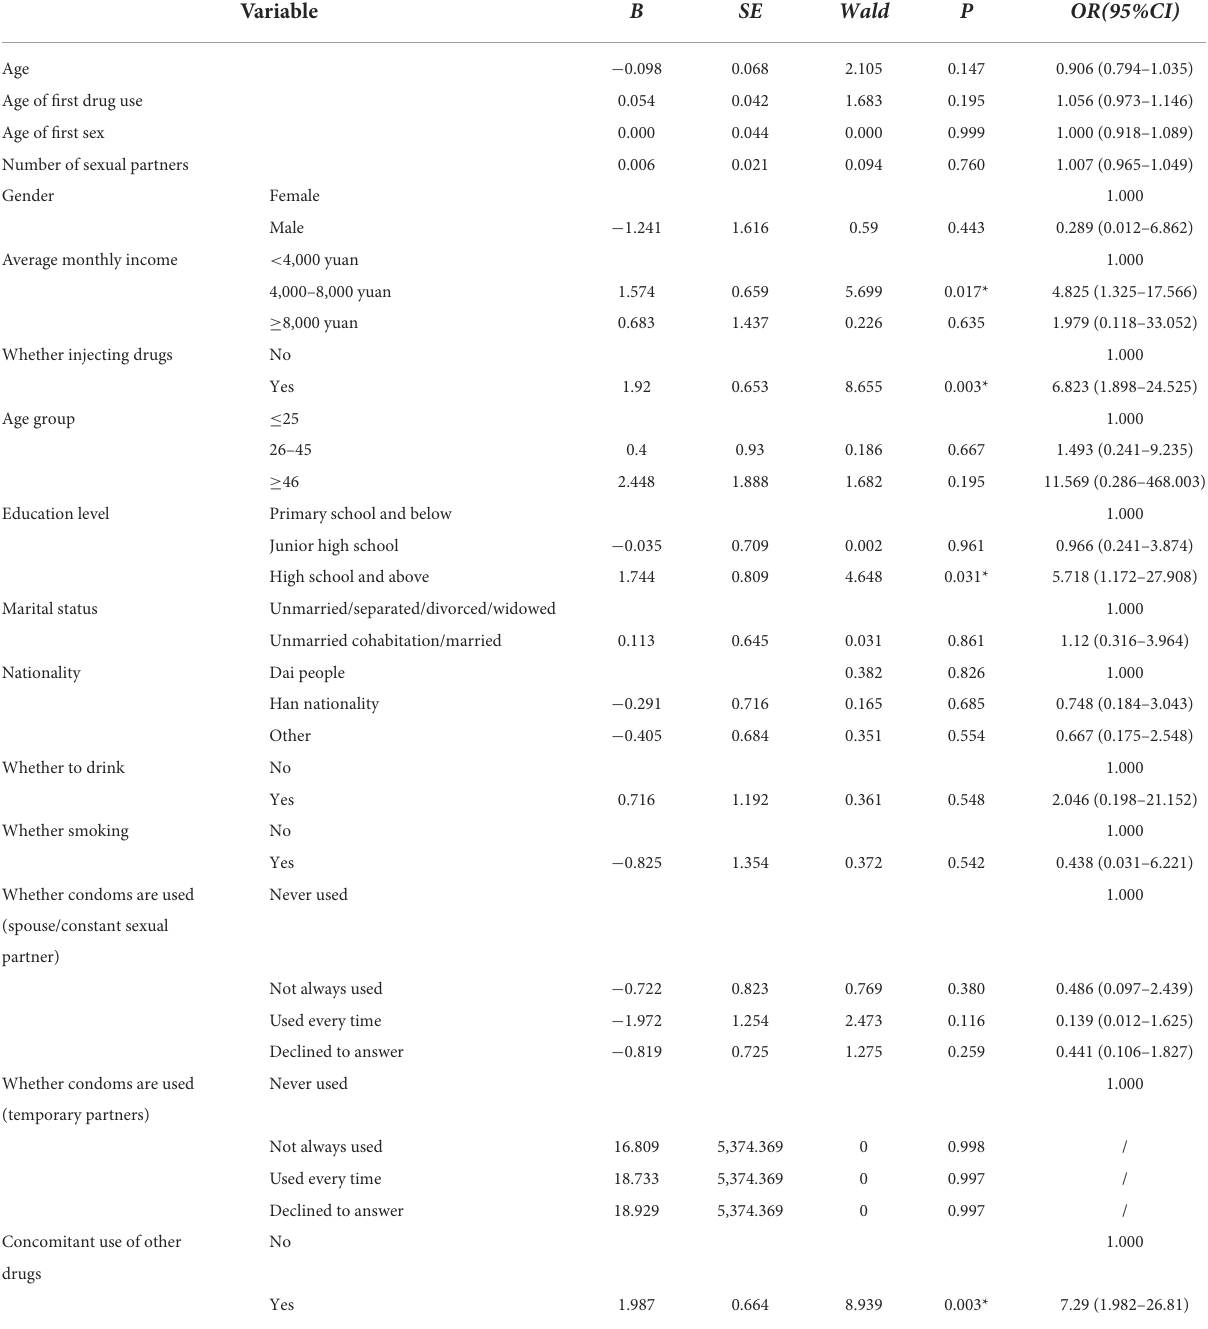
TABLE 4 Multivariate logistic regression analysis of risk factors for anti-HCV positive